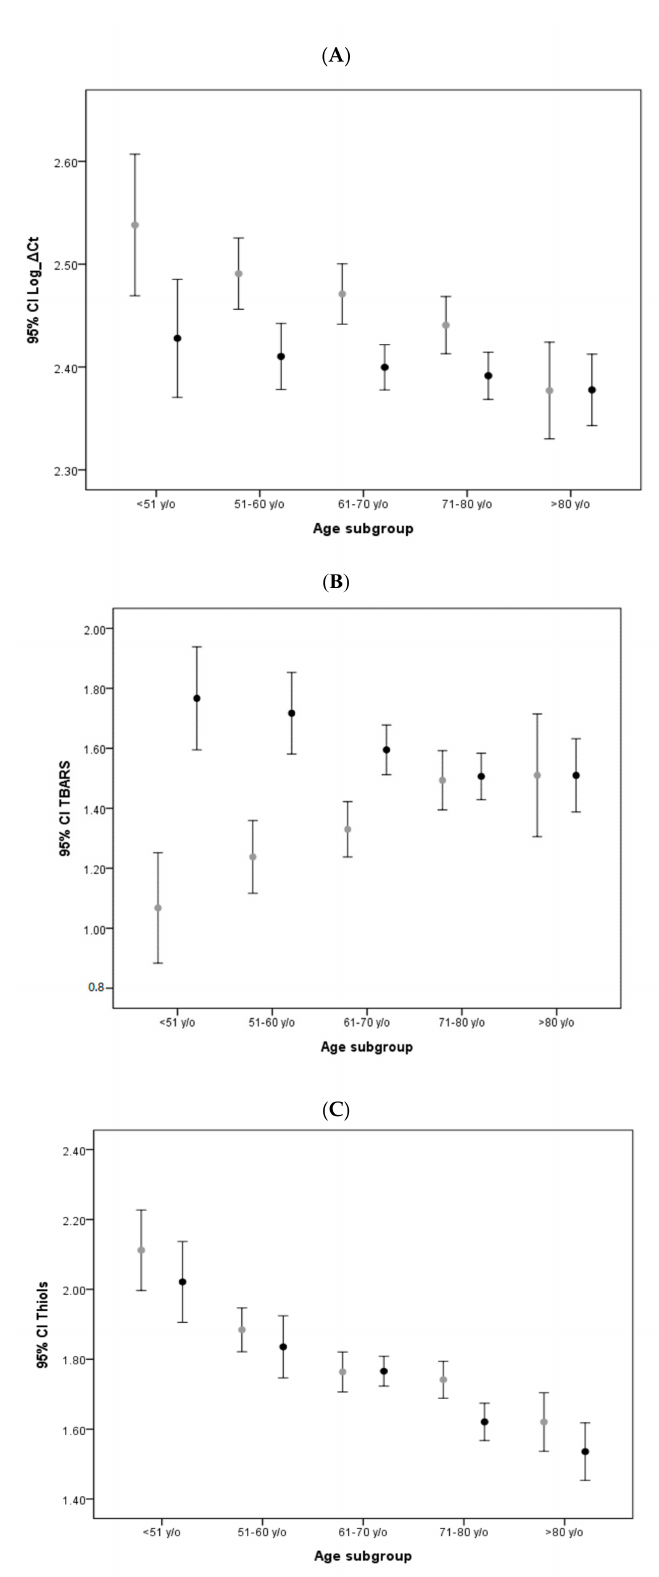
Figure 1. Age-stratified comparison of oxidative stress markers and mtDNA copy number between PD patients and non-PD controls: Error bar plots show levels of average Log ∆ Ct copy number ( A ), TBARS ( B ), and thiols ( C ) in di ff erent age subgroups of PD patients and non-PD controls. ( • in ( A – C ) represents PD patient group; • in ( A – C ) represents non-PD control